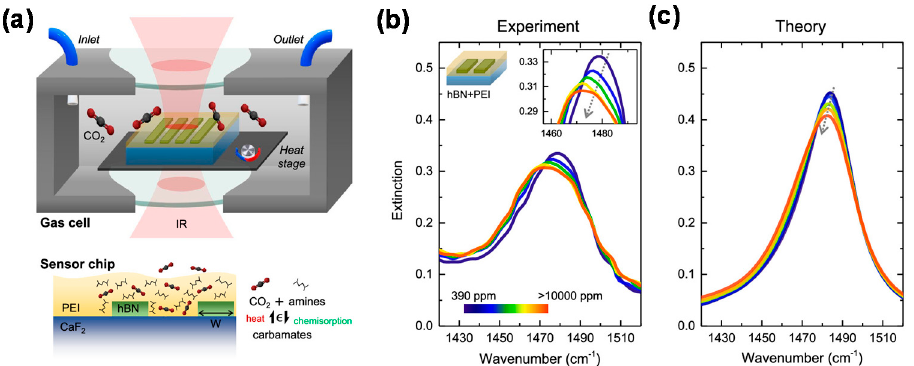
Figure 12. ( a ) Schematic of the CO 2 gas sensing setup and sensor chip using hBN nanoribbons. Extinction spectra for CO 2 : ( b ) experimental and ( c ) theoretical results. Adapted from [109] under CC BY 4.0.